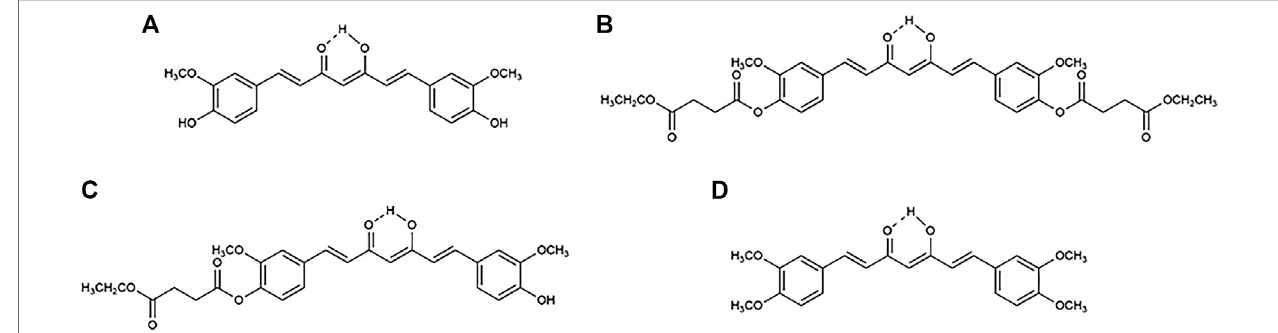
FIGURE 1 | Chemical structures of (A) curcumin, (B) curcumin diethyl disuccinate (CDD), (C) monoethylsuccinyl curcumin (MSCUR), and (D) dimethylcurcumin (DMC).